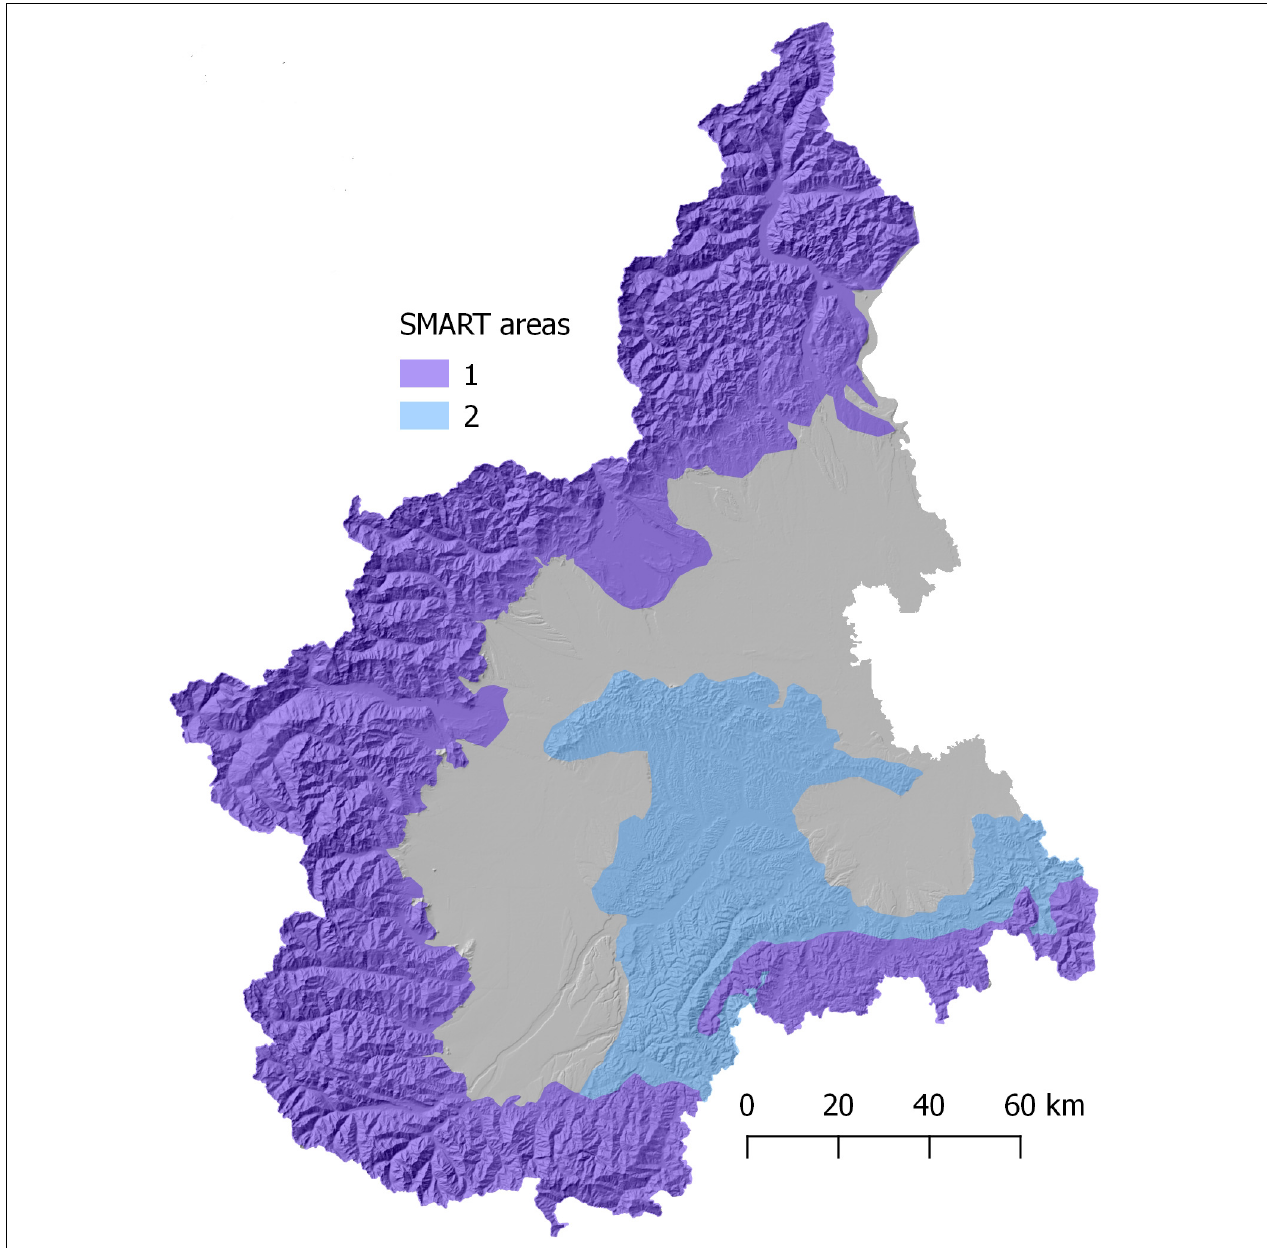
FIGURE 3 | SMART homogeneous areas. Area 1: Alpine and Apennines environments characterized by metamorphic bedrock and high rainfall values to trigger shallow landslides; Area 2: hilly environment characterized by sedimentary bedrock and moderate rainfall values to trigger shallow